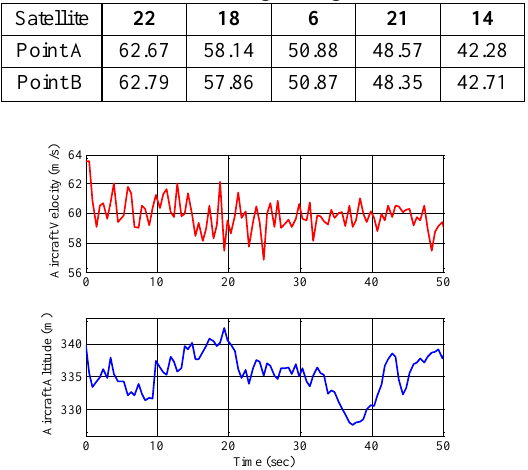
Figure 11. WGS84 altitudes of the sea surface points (top) and relative sea surface elevation (bottom) measured by LiDAR.